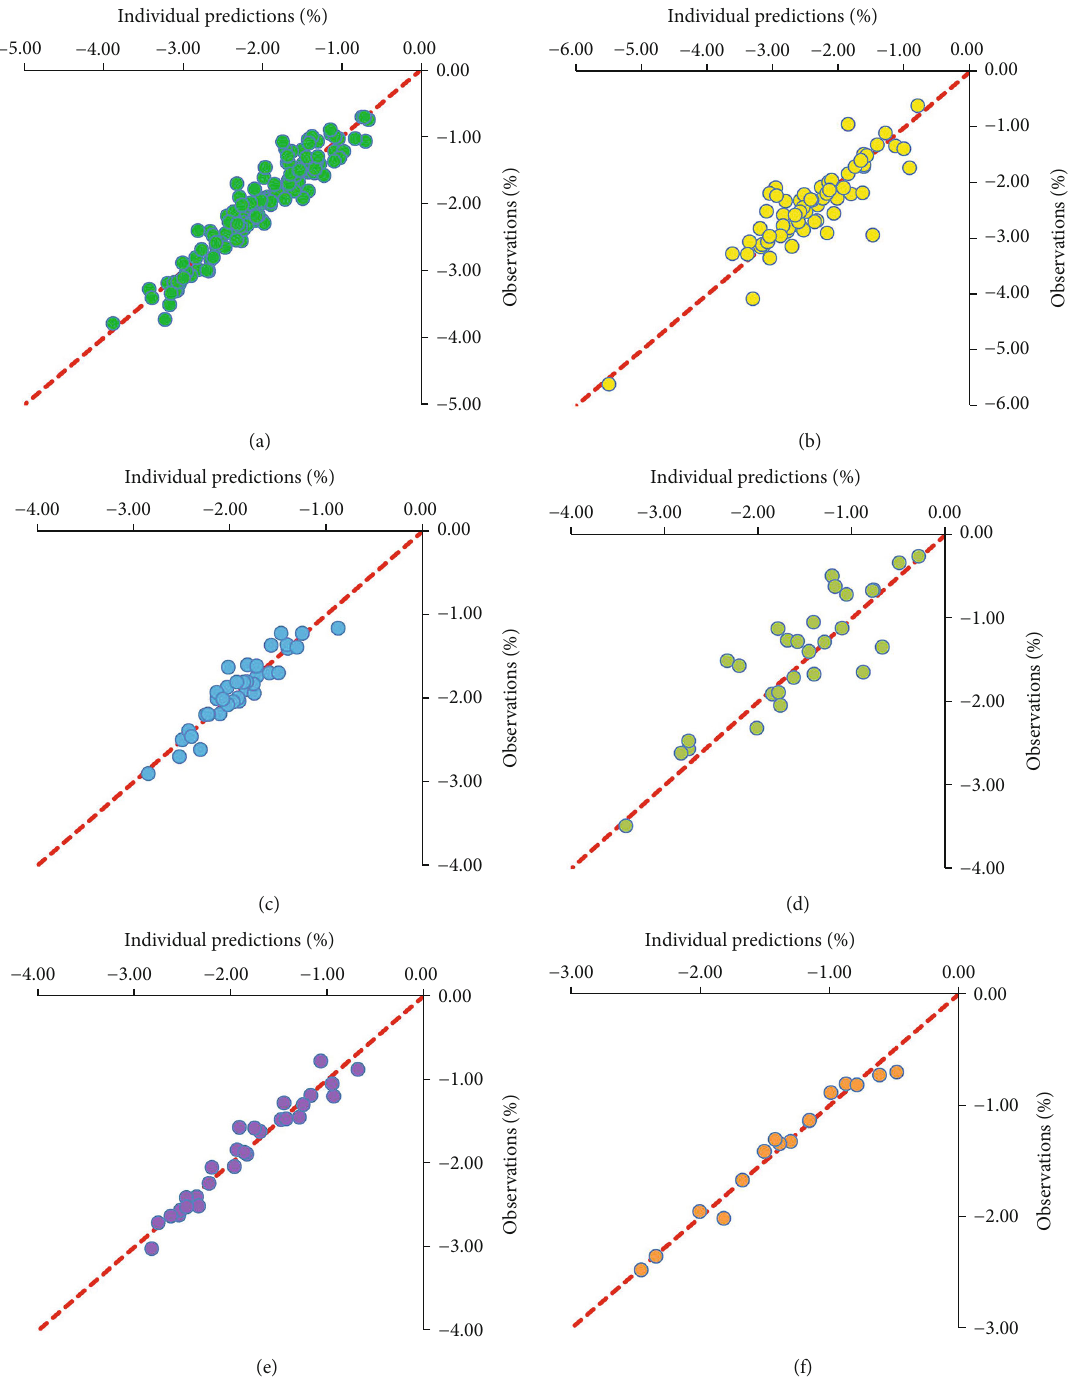
Figure 1: Visual inspection of routine diagnostic plots: (a) canagli fl ozin, (b) empagli fl ozin, (c) ertugli fl ozin, (d) ipragli fl ozin, (e) luseogli fl ozin, and (f) tofogli fl